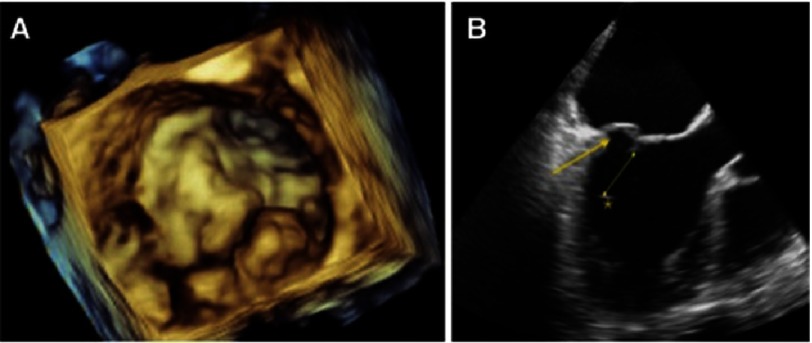
3D transesophageal echocardiography surgical view of P1-P2 segments of a mitral valve prolapse (A).2D off line reconstruction from 3D full volume LV acquisition. Arrow: P2 prolapse, Line: Primary Chords elongation. Asterisk shows a papillary muscle tip displacement and high intensity echogenicity.